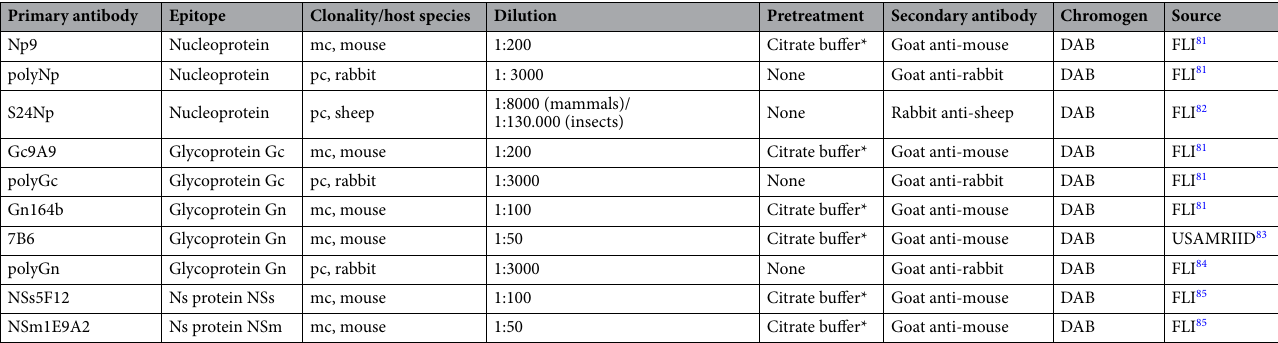
Table 1. List of antibodies tested to detect RVFV. *: Microwaved in citrate buffer for 20 min at 600 W; DAB: 3,3 ′ -diaminobenzidine; FLI: Friedrich–Loeffler-Institute, Greifswald; mc: monoclonal; Ns: non-structural, pc: polyclonal; USAMRIID: United States Army Medical Research Institute of Infectious Diseases, Fort Detrick, Maryland,